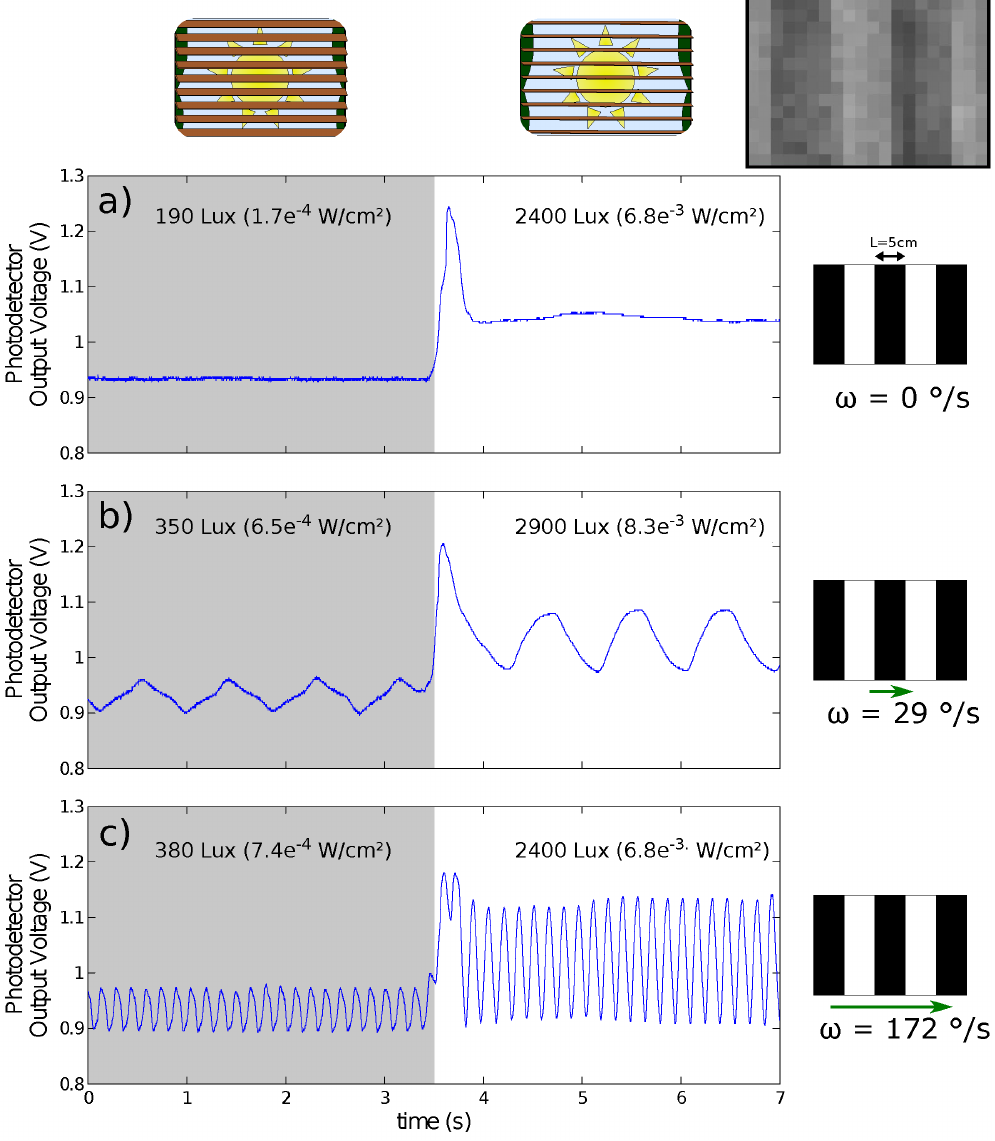
Response of one CurvACE element (a photodetector with optics) to sharp changes in the illuminance (obtained by opening a sun-blind) after digitizing and sampling the data at a frequency of 500 Hz. The photodetector output signal was recorded while facing a periodic pattern (a set of stripes with a width of 50 mm placed 195 mm from the sensor) exposed to natural lighting conditions) ( a ) stationary (static state) and translating at a speed of ( b ) 29 ◦ /s and ( c ) 172 ◦ /s. The photodetector compensated quickly (about 0.5 s) for the increase in the illuminance and adapted its gain, as well as amplified the transient signals generated by the moving pattern. The inset (upper right corner) shows the periodic pattern acquired by the CurvACE sensor at a distance of 15 cm with a region of interest composed of 20 by 15 ommatidia under a lighting of 1500